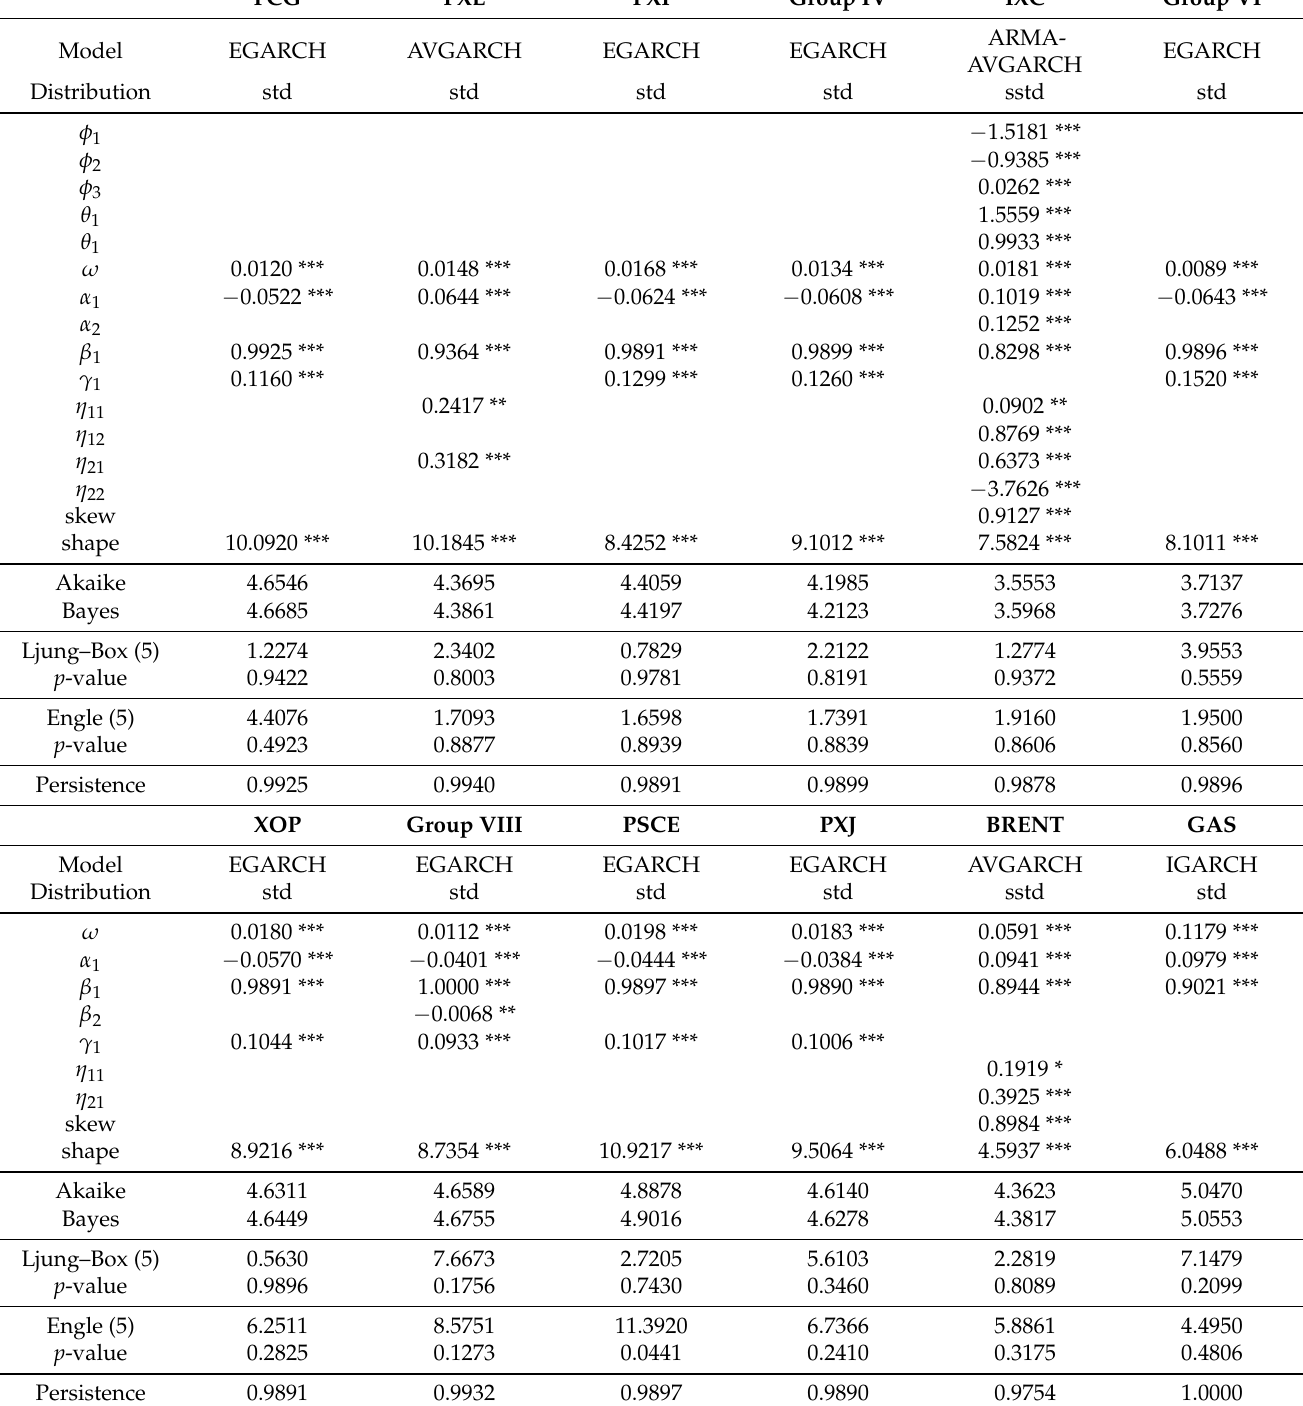
Table A5. Family ARMA-GARCH